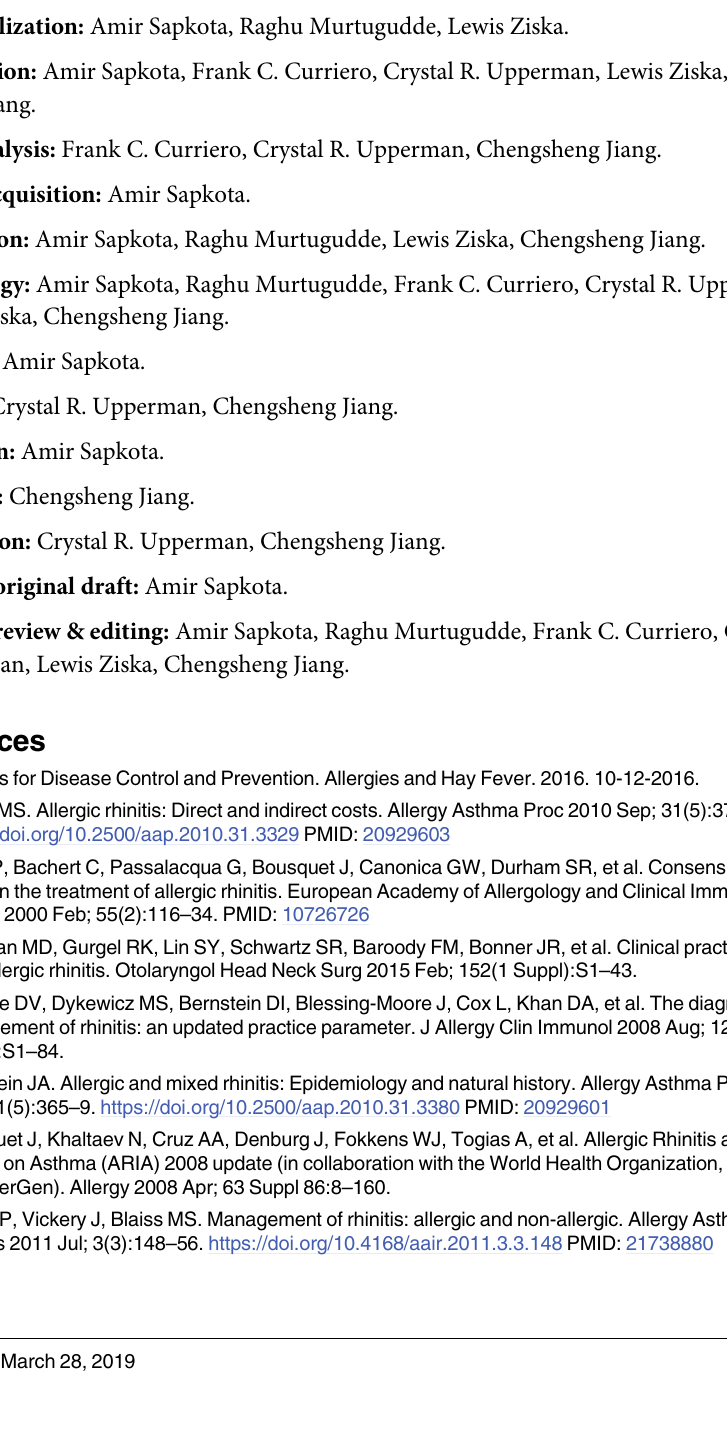
S1 Table. Distribution of respondents across exposure categories (SOS) by survey year.